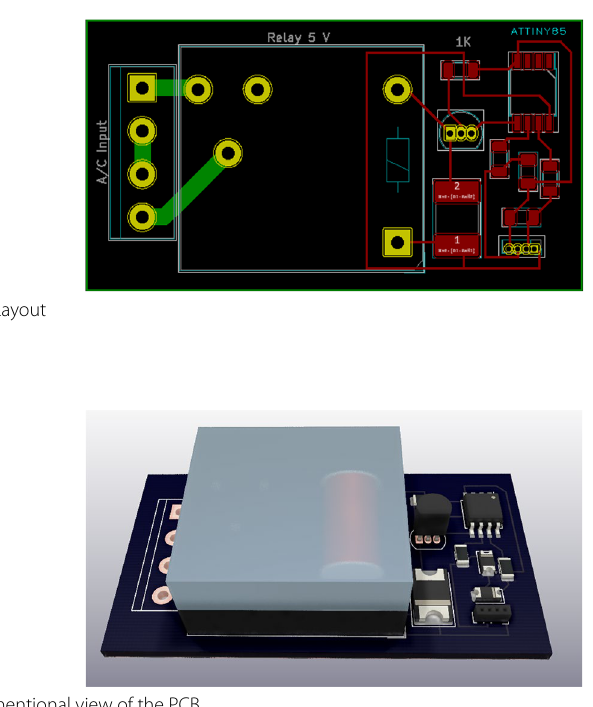
Figure 6 portrays the 3-D rendered image of the proposed winder. The DC input is connected using male–female jumper cables while the mains current for synchronous motor is directly soldered to the board. To the shaft of the synchronous motor, an enclo- sure in which the watch is placed is coupled about an axis perpendicular to the axis of the shaft. During scheduled intervals, the relay switches the motor and the shaft along with the enclosure and watch rotates thereby winding the mainspring of the caliber. The prototype of the model is made using a 9 RPM single-phase Synchronous motor, Attiny85 module and 5-V single-pole double-throw relay module. The watch is fixed intact on the base and the base is screwed directly to the shaft of the motor. Figure 7 depicts the prototype of the